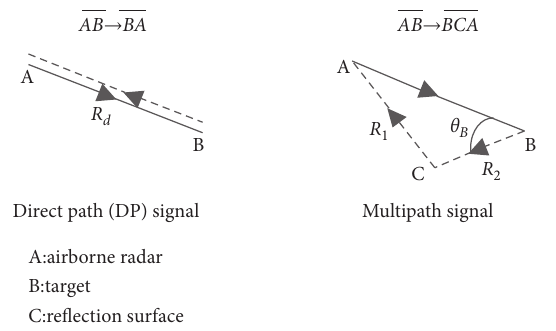
Figure 2: The simplified signal model in a multipath